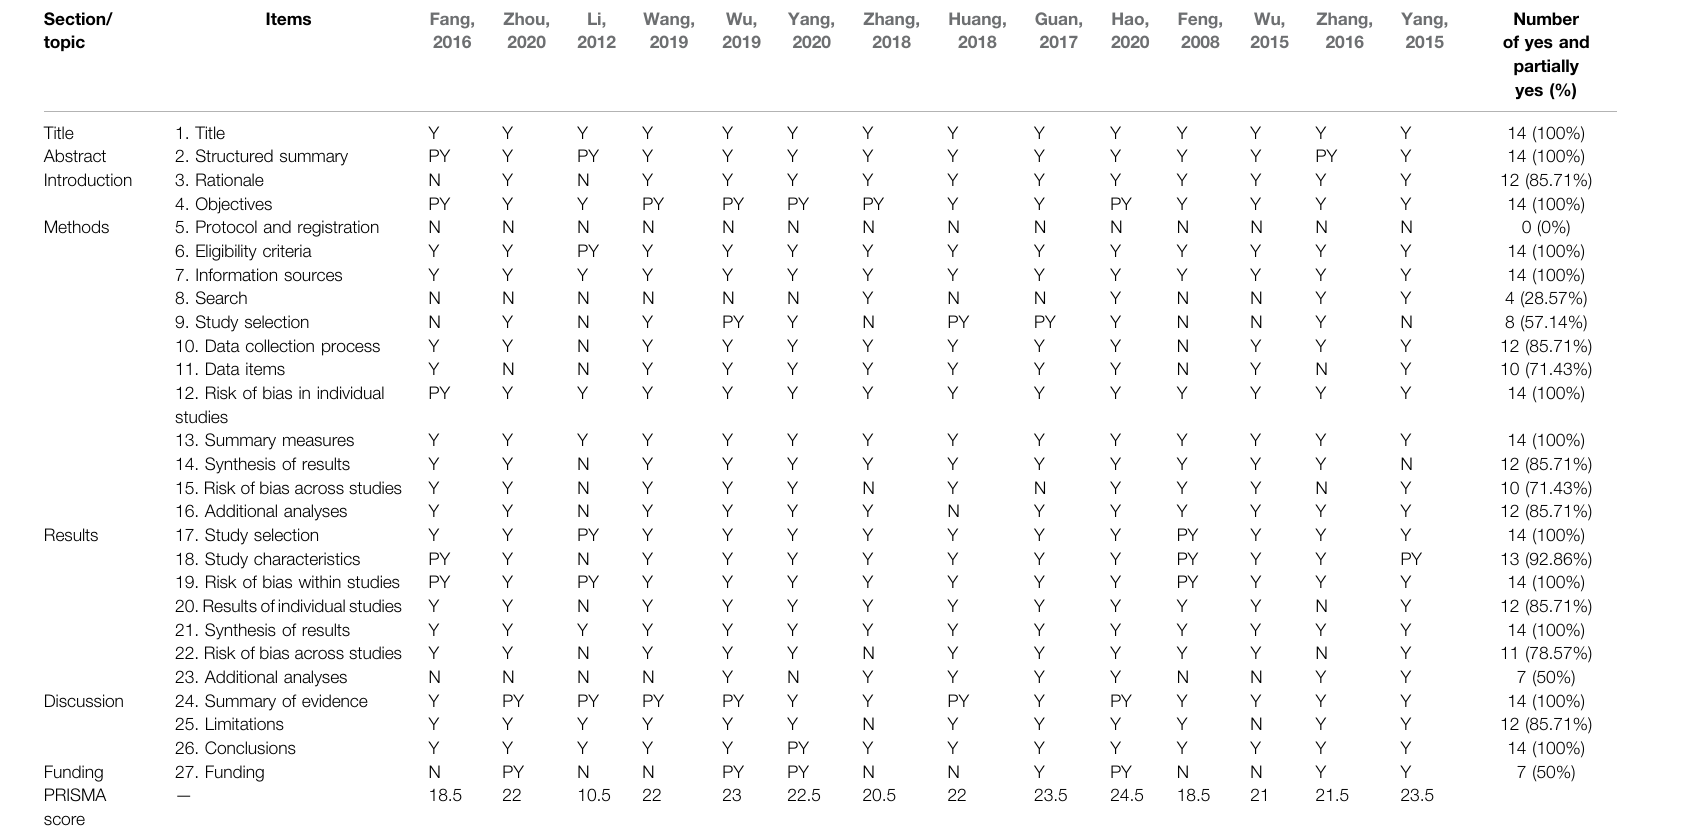
TABLE 5 | Results of the PRISMA